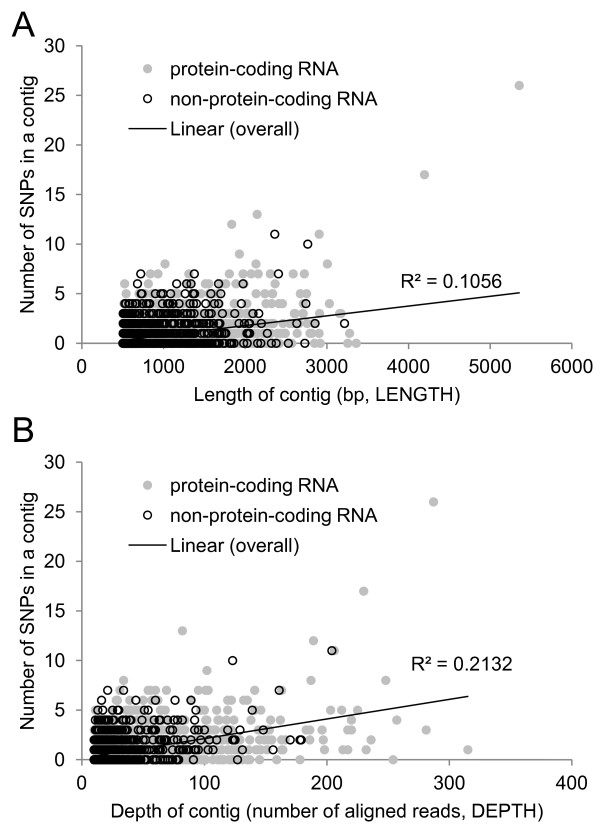
Correlations between the number of SNPs and both length and depth of contigs. Positive correlations between the number of SNPs and both (A) length and (B) depth of contigs with depth of ≥10 reads and length of ≥501 bp. In both cases, P < 0.001.